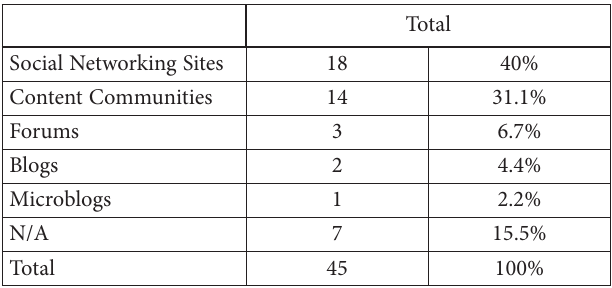
Table 6. Social media platforms investigated (source: authors,